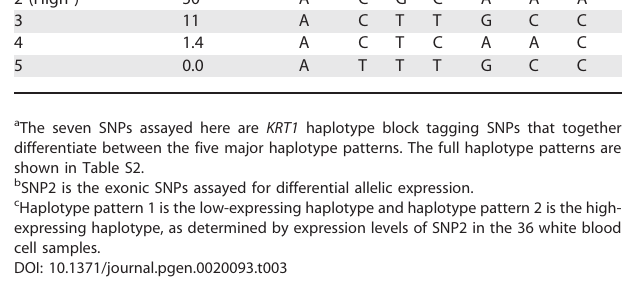
Table 3. Frequency of KRT1 Block Haplotype Patterns in the 36 White Blood Cell Samples